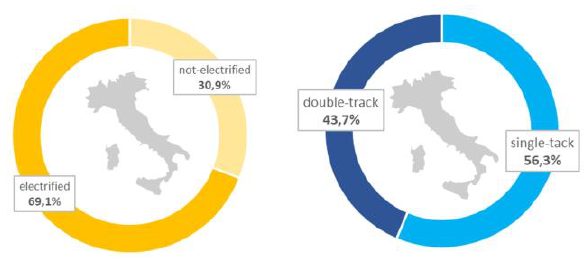
Figure 1. Italian regional railways: electrification and number of tracks (Legambiente,